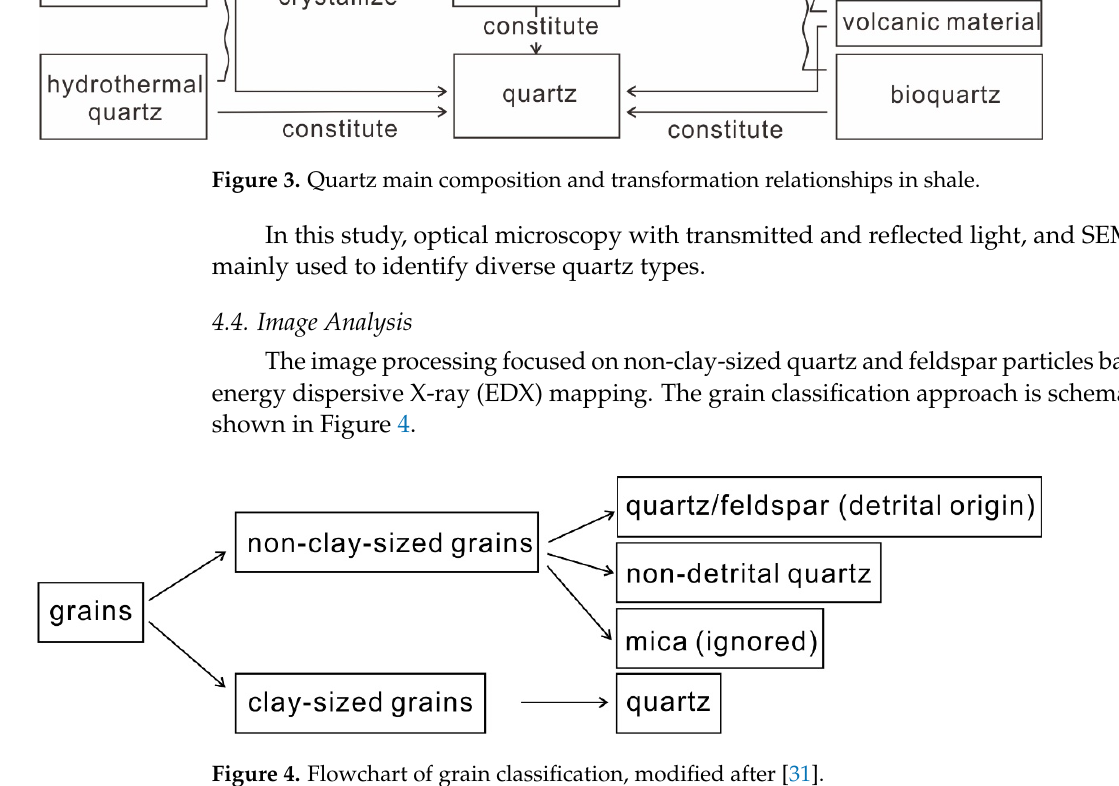
Figure 4. Flowchart of grain classification, modified after [31].